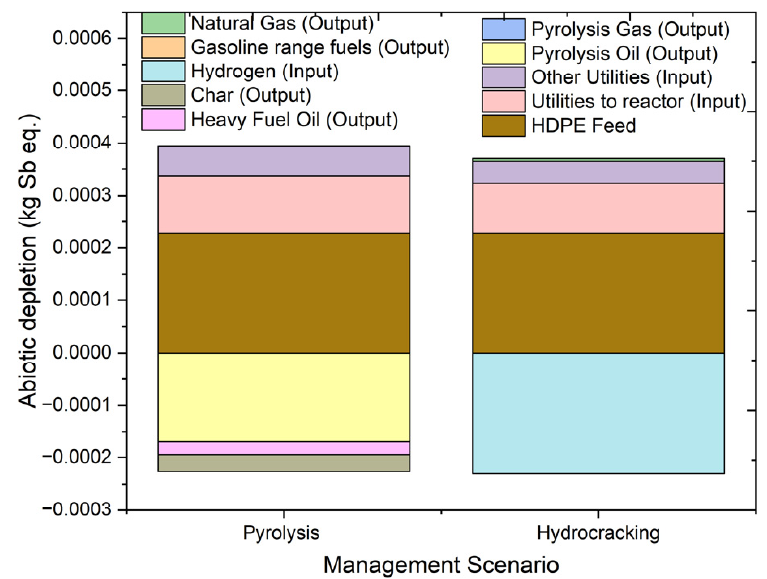
Figure 7. Impact assessment of pyrolysis and hydrocracking for the management of waste HDPE on depletion of abiotic resources (kg Sb eq.).